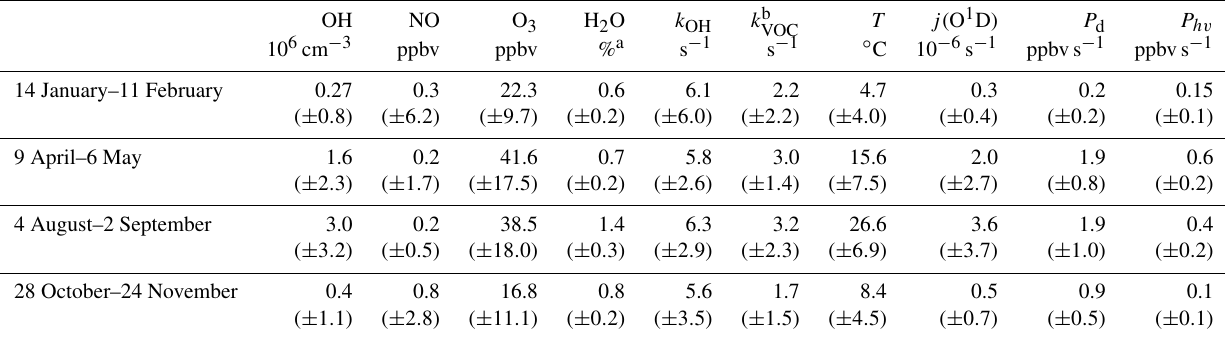
Table 3. Summary of meteorological conditions and trace gas concentrations during JULIAC given as daytime median values with 1 σ standard deviations of ambient